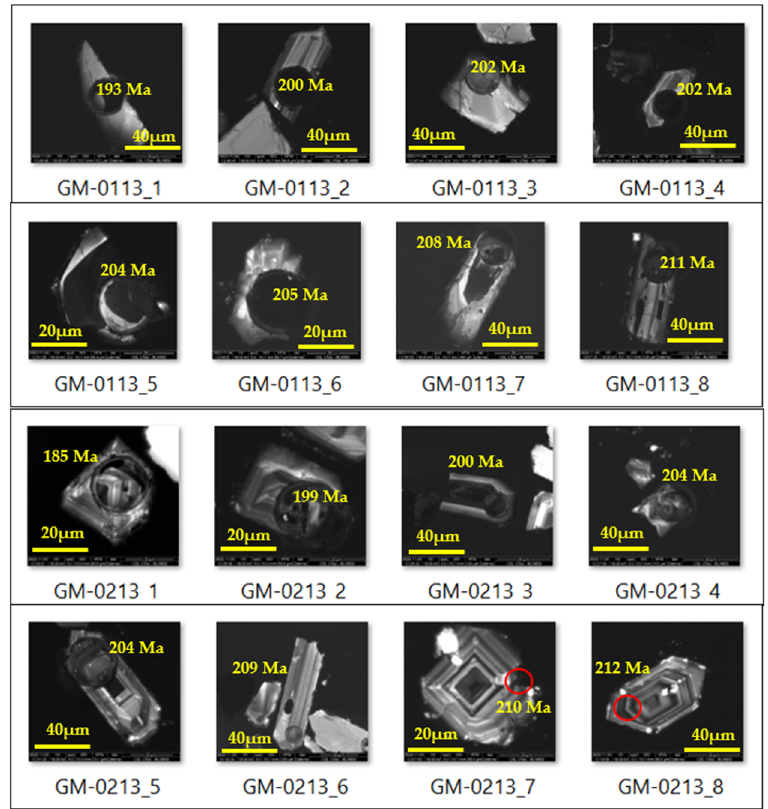
Figure 8. Cathodoluminescence (CL) images of zircon grains from the Gua Musang area, Malaysia. The round feature represents the position of the laser craters.